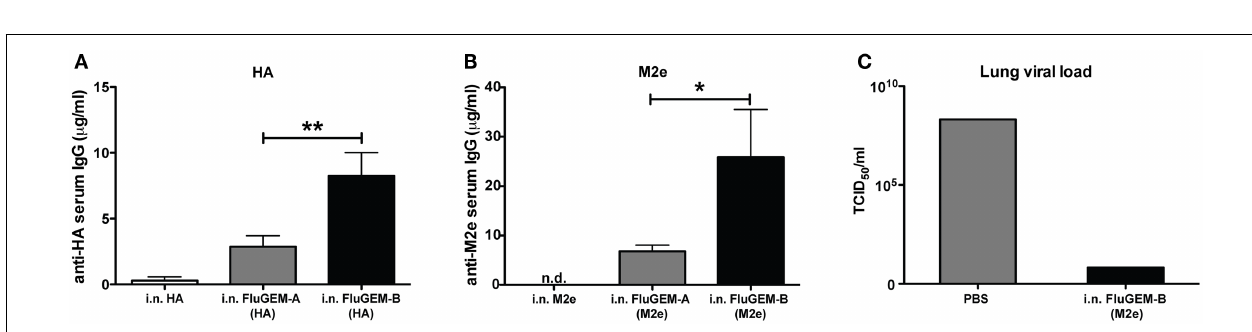
FIGURE 5 | Immune responses induced upon i.n. vaccination with FluGEM-A and FluGEM-B . Groups of 10 mice were vaccinated i.n. with HA- or M2e-based FluGEM-A or FluGEM-B.Vaccination dose in the case of HA-based vaccines (A) was 1 µ g HA mixed with or bound to 0.3mg BLP. Animals received in total three doses (day 0, 10, and 20) and were sacrificed 2weeks after the final immunization (day 34).Vaccination dose in the case of M2e-based vaccines (B) was 6 µ g M2e equivalent mixed with or bound to 0.38mg BLPs. Animals received in total three doses (day 0, 21, and 42) and were sacrificed 3weeks after the final immunization (day 63). In both cases physical coupling of the